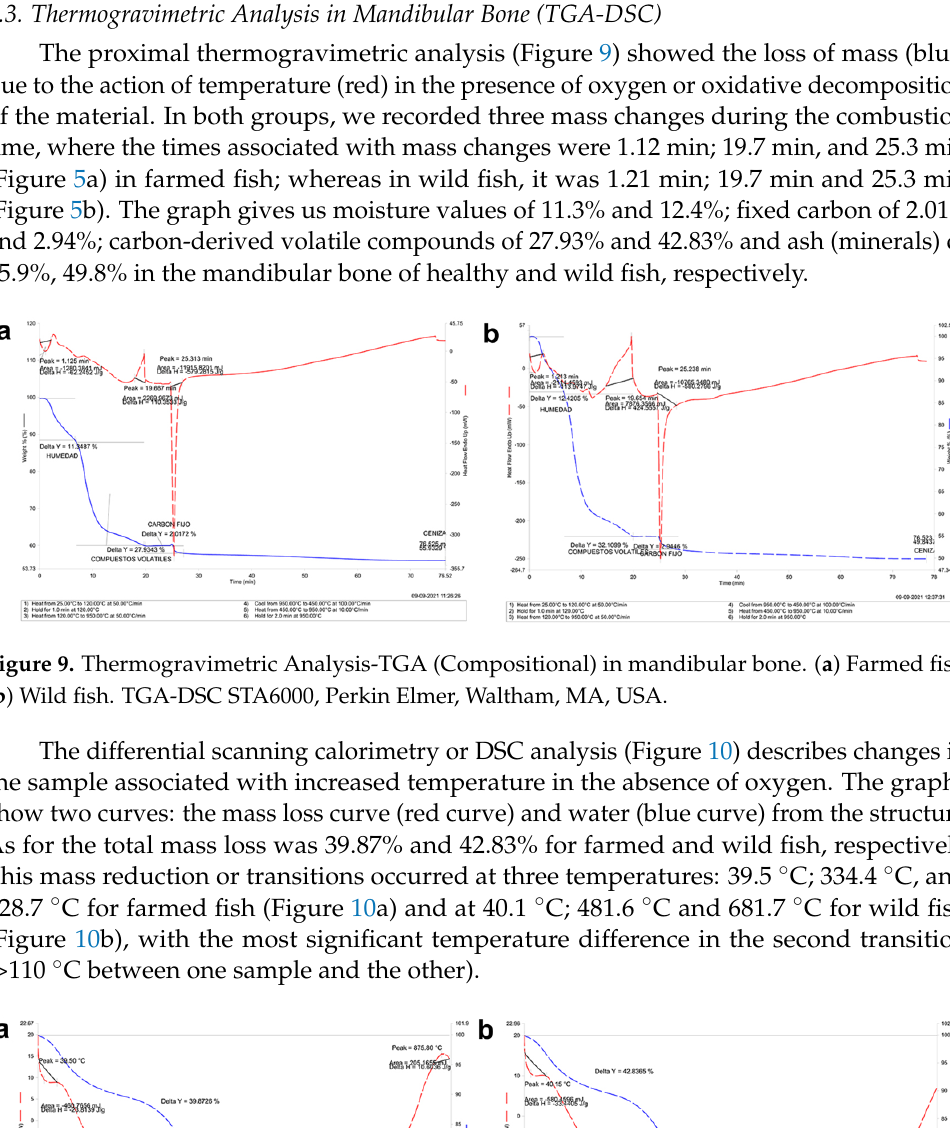
Table 5. Porosity analysis in jaw of rainbow trout ( Oncorhynchus mykiss ).